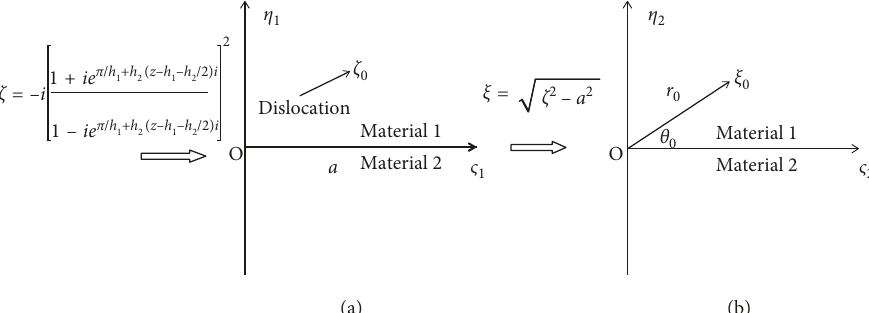
Figure 3: A screw dislocation interaction with an edge interfacial crack in the right semi-infinite plane piezoelectric